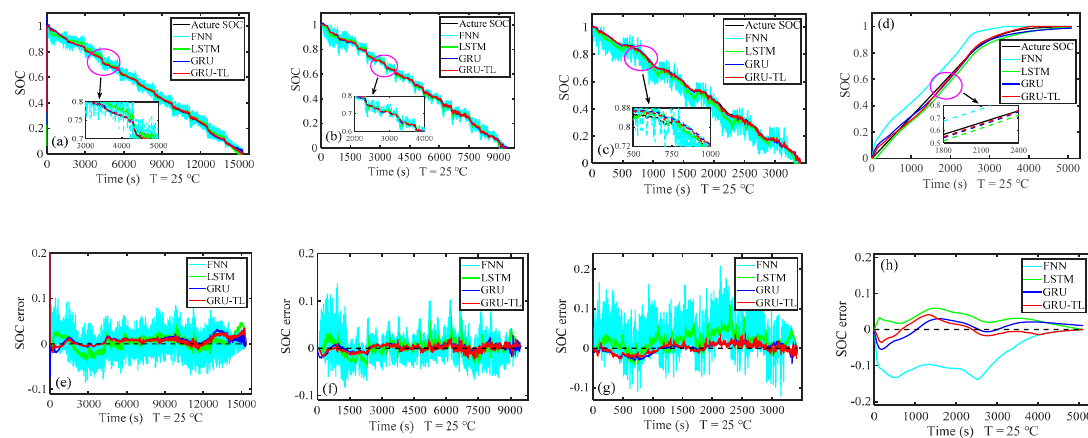
Figure 4. State-of-charge (SOC) and SOC error of four network models at 0 °C: ( a ) and ( e ) Urban Dynamometer Driving Schedule (UDDS), ( b ) and ( f ) LA92, ( c ) and ( g ) US06, ( d ) and ( h ) constant charge and constant voltage (CC-CV).